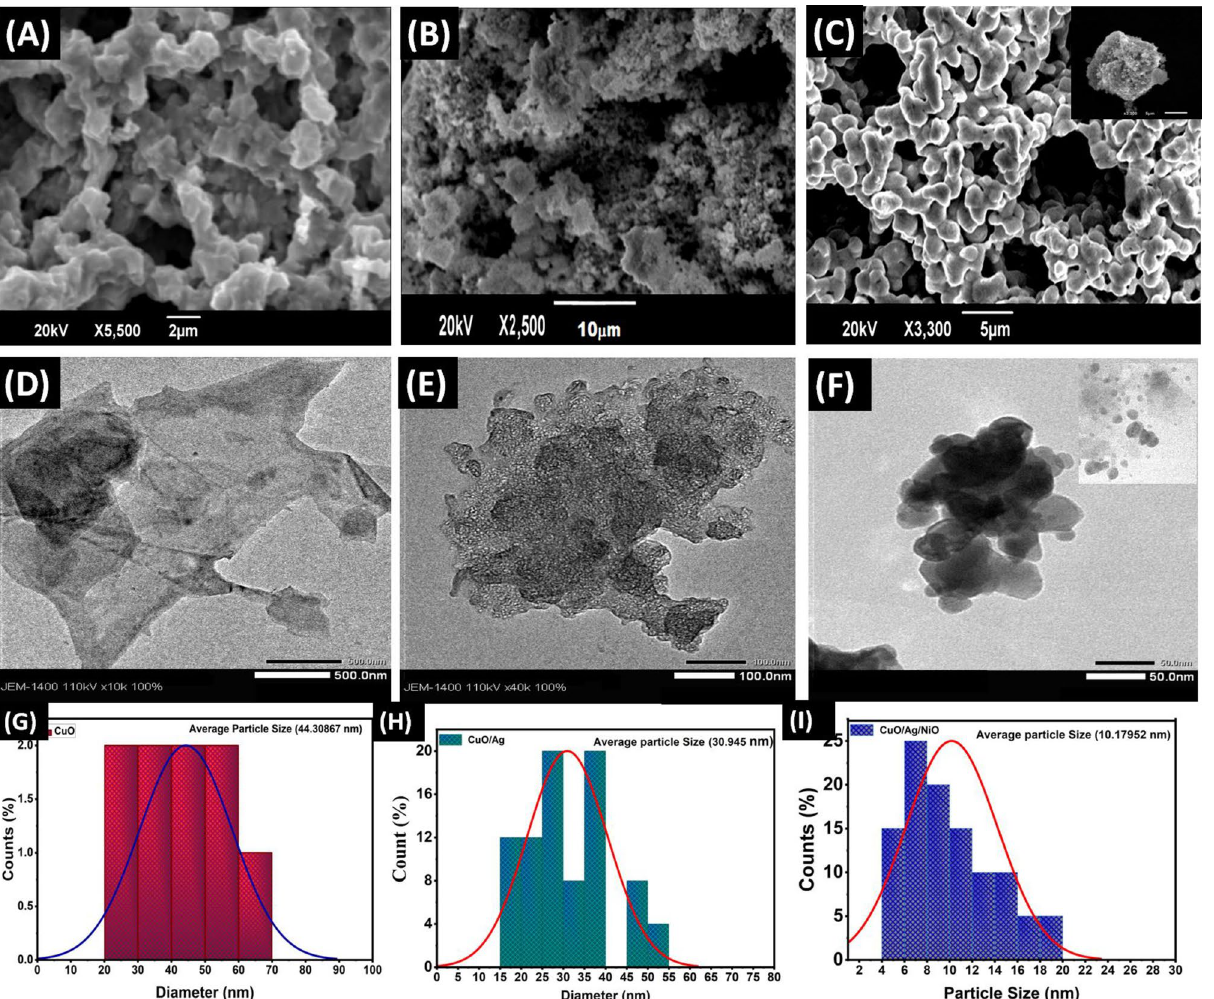
Figure 2. SEM images of ( A ) CuO, ( B ) CuO/Ag, ( C ) CuO/Ag/NiO, and inset image shows the agglomeration of CuO/Ag/NiO; TEM images of ( D ) CuO, ( E ) CuO/Ag, and ( F ) CuO/Ag/NiO, The diameter distribution of ( G ) CuO, ( H ) CuO/Ag and ( I )